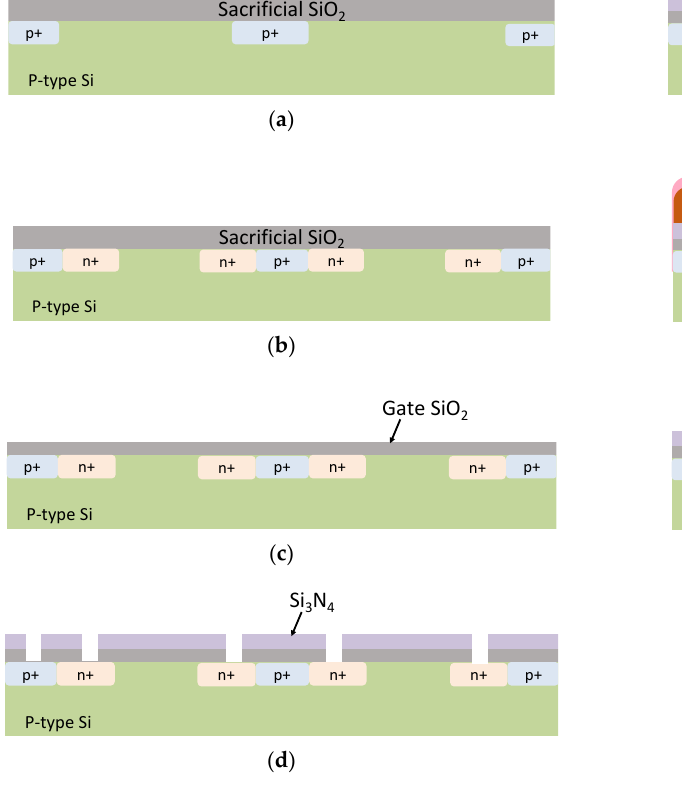
Figure 2. Cross-section diagram showing the fabrication process of the proposed device. ( a ) Sacrificial oxide formation and channel stopper ion implantation. ( b ) Source/drain ion implantation. ( c ) A new layer of gate oxide (SiO 2 ) is formed. ( d ) Deposition of Si 3 N 4 , and source/drain contact opening. ( e ) Aluminum contact sputtering. ( f ) Deposition of SnO 2 on top of a photoresist mask. ( g ) Lift-off of photoresist mask.